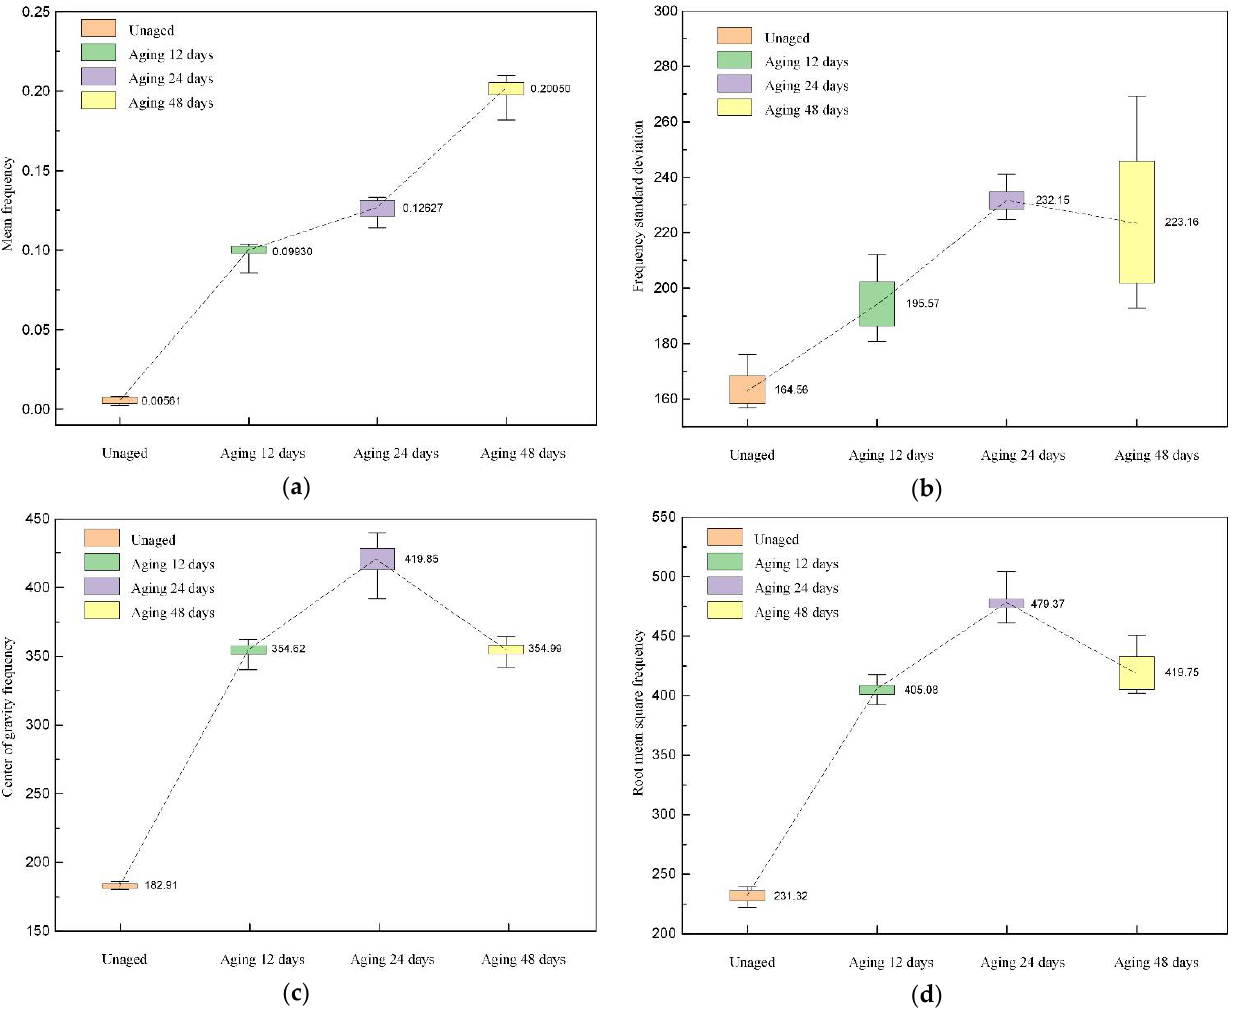
Figure 11. The distribution of frequency-domain parameters. ( a ) Mean frequency; ( b ) frequency standard deviation; ( c ) center of gravity frequency ( d ) root-mean-square frequency.